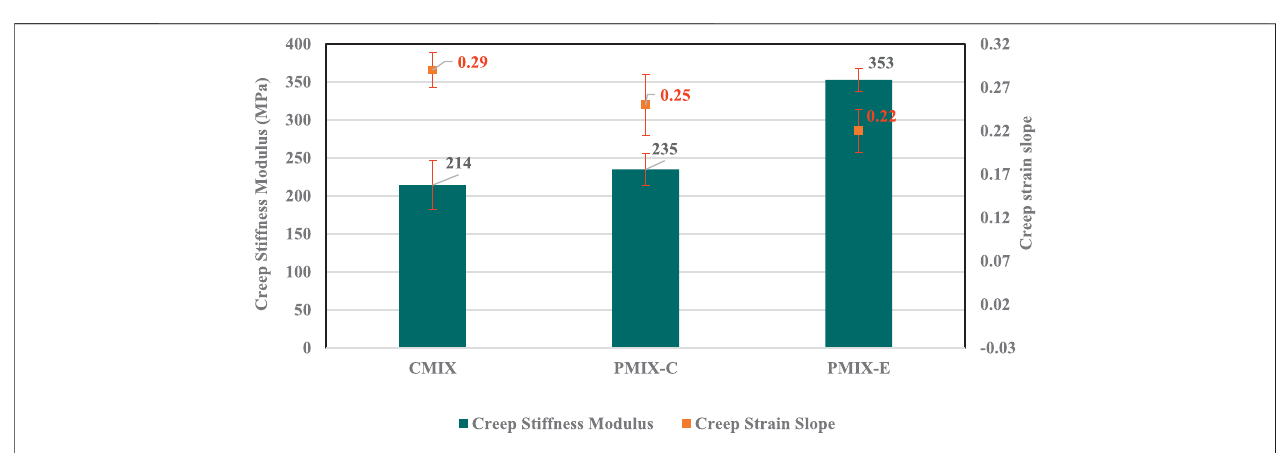
FIGURE 10 | Values of creep stiffness modulus and creep strain slope of the control, PMIX-C and PMIX-E mixtures.